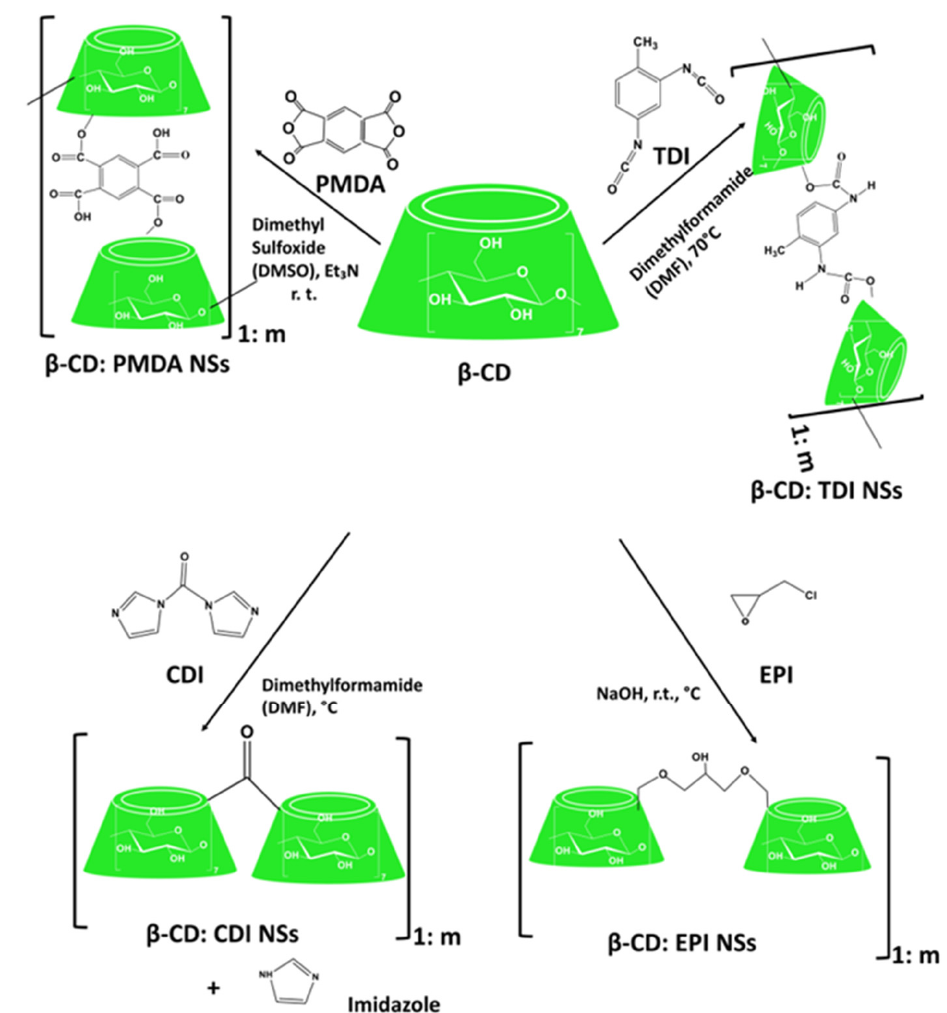
Figure 12. Schematic representation of the synthesis of cyclodextrin (CD)-based ester (PMDA), ether (EPI), carbonate (CDI), and urethane (TDI) nanosponges (NSs). Cyclodextrin-Based Carbonate Cyclodextrin-Based Urethane Nanosponges Diisocyanates such as hexamethylene diisocyanate (HDI), toluene-2,4-diisocyanate (TDI), are used to synthesize urethane (or carbamate) CD-NSs, and are characterized by a very low surface area (1–2 m 2 /g), high resistance to chemical degradation, rigid structure, and a negligible swelling in organic solvent and water [263,285].